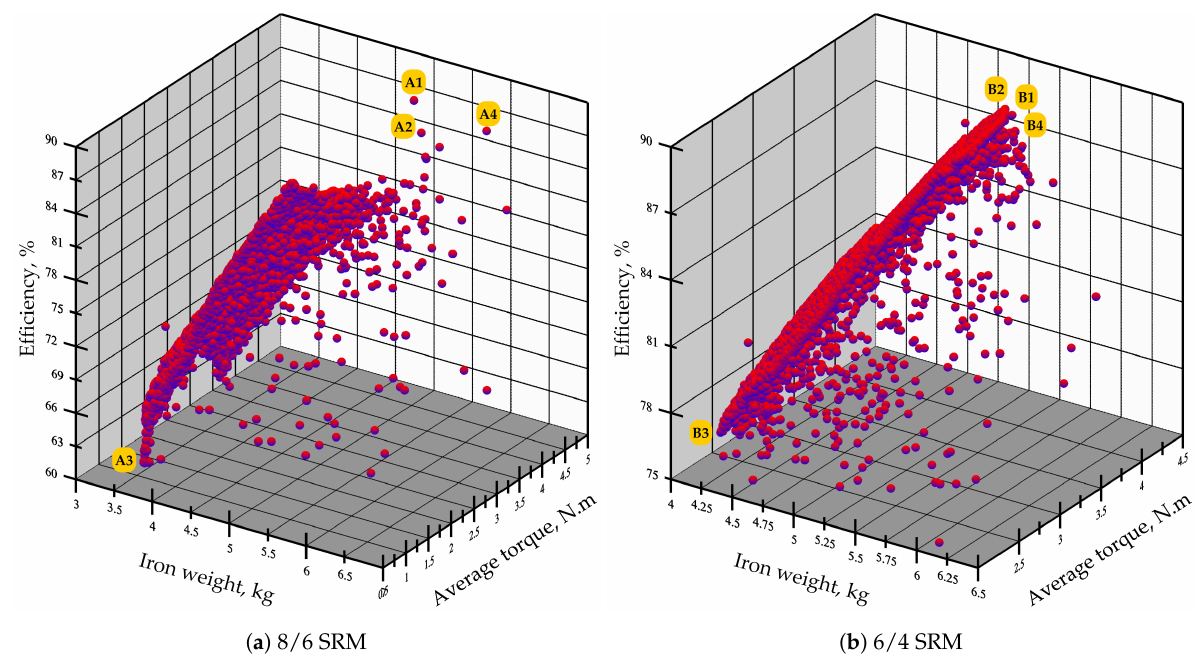
Figure 8. 3D representation of objective functions values through optimization